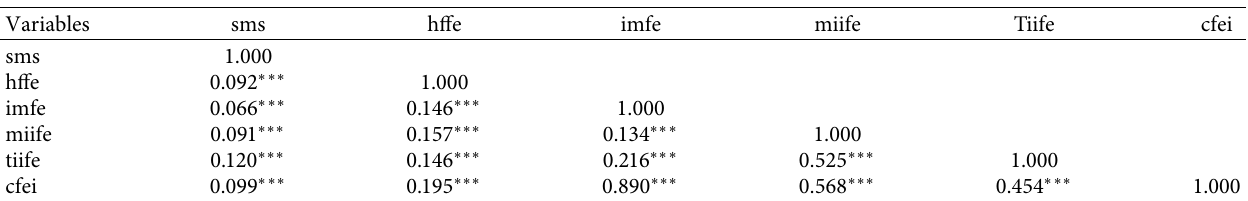
Table 4: Correlations between fnancial education and consumer stock market